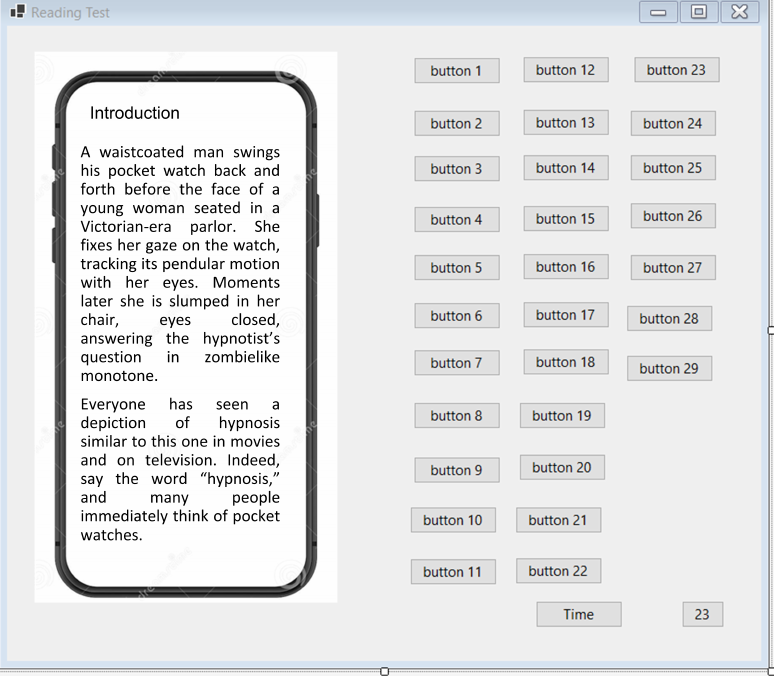
Figure 3. GUI of Mobile Screen.